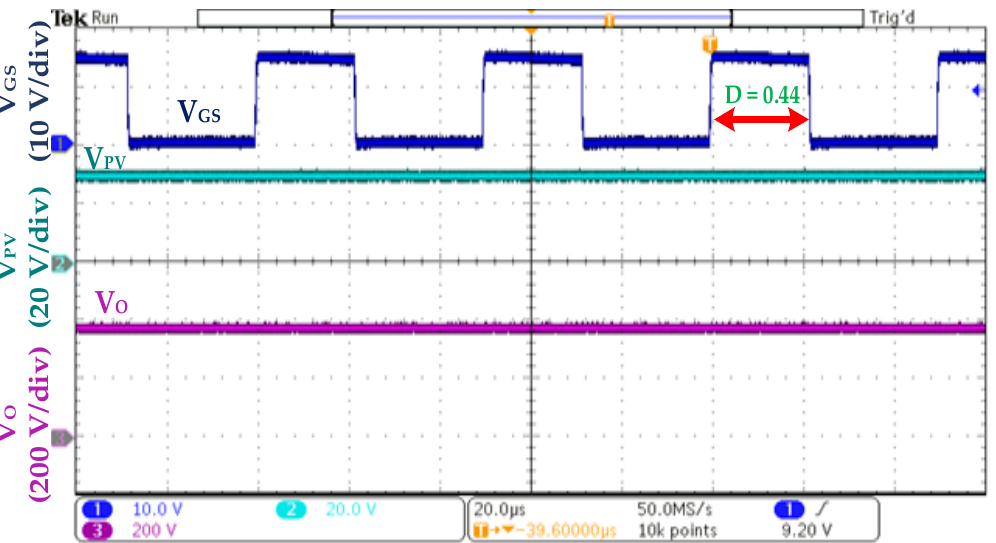
Figure 18. Experimental waveform for the gate source voltage (V GS ), solar photovoltaic simulator output voltage (V PV ), and output voltage (V o ) for the proposed HVGSU converter at the 0.44 duty cycle (Hor: 20 µs/div).